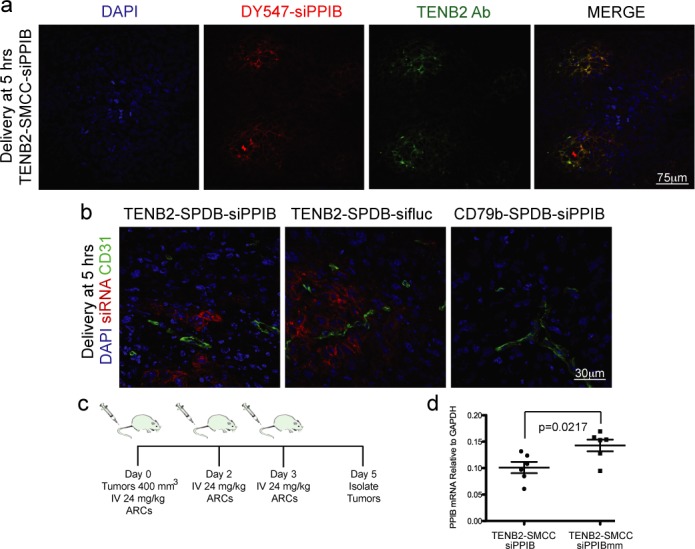
ARCs are delivered to tumors in vivo and mediate silencing. (a) TENB2 antibody and siRNAs (Dy-547 labeled) are co-delivered to tumor cells within 5 h after intravenous injection of ARCs. (b) Visualization of siRNAs (Dy-547 labeled) and the endothelial cell maker CD31 in tumor sections reveals siRNA delivery to tumor cells near the vasculature in a manner that depends on the targeted antibody–antigen interaction. (c) Schematic of in vivo silencing study. We dosed mice bearing tumors with a volume of ∼400 mm3 three times with 24 mg/kg (total ARC mass in mg per body weight in kg, equivalent to ∼20.6 mg/kg antibody plus 3.4 mg/kg siRNA) of ARCs and harvested tumors on day 5. (d) Assessment of TENB2 ARC induced silencing in vivo (in EpCam+ cells isolated from near the CD31+ tumor vasculature); PPIB mRNA levels, normalized to GAPDH mRNA levels, are shown for each animal (N = 6 for each group, SD shown, Student's t-test: P = 0.0217).